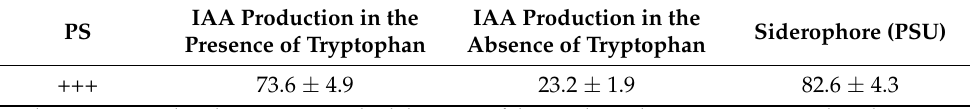
Figure 5. Plant growth-promoting traits of RDA1. ( a ) Positive indole acetic acid (IAA) production in the culture containing RDA1. The extreme lower well with pink color was used as positive control and the middle well was used as a negative control. IAA detection was indicated by a change in the color from yellow to pink in the test sample. ( b ) Phosphate solubilization assay. The growth of RDA1 on a NBRIP medium (a closer look at the clearing area surrounding the bacterial colony). Table 1. Plant growth-promoting characteristics of